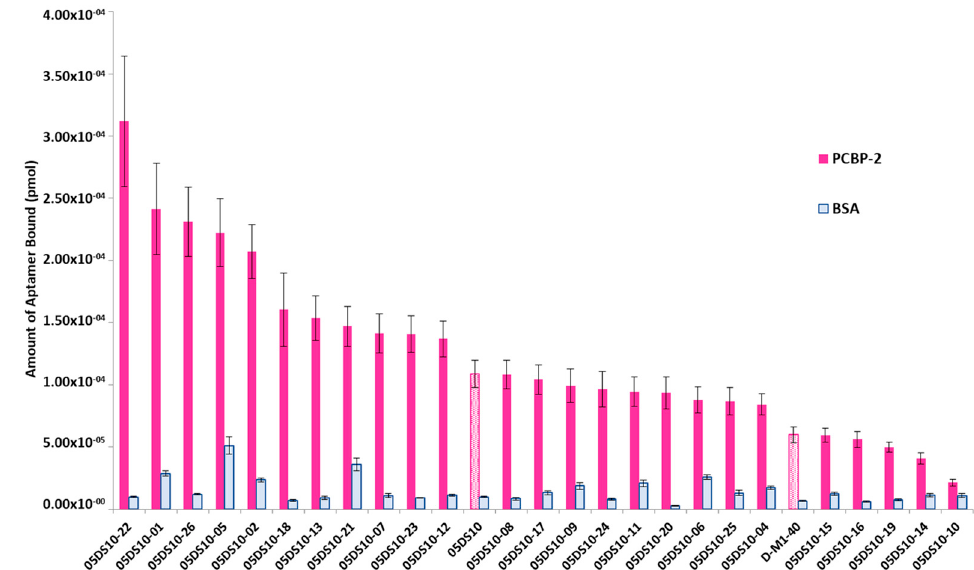
Figure 3. Screening of the PCBP-2 binding affinity of the ssDNA aptamers selected after 10 rounds of SELEX process, using ELONA-qPCR. Recovered aptamers were amplified by qPCR, and the Ct values (see text for details) were interpolated within the previously constructed calibration curve (Figure 2A) to quantify the amount of aptamer (pmol) bound to PCBP-2. The mean and standard deviation values of three independent experiments are shown. The whole aptamer population present at the final SELEX round (05DS10) and the random population used as the starting material for the selection process (D-M1-40) were assayed in parallel.